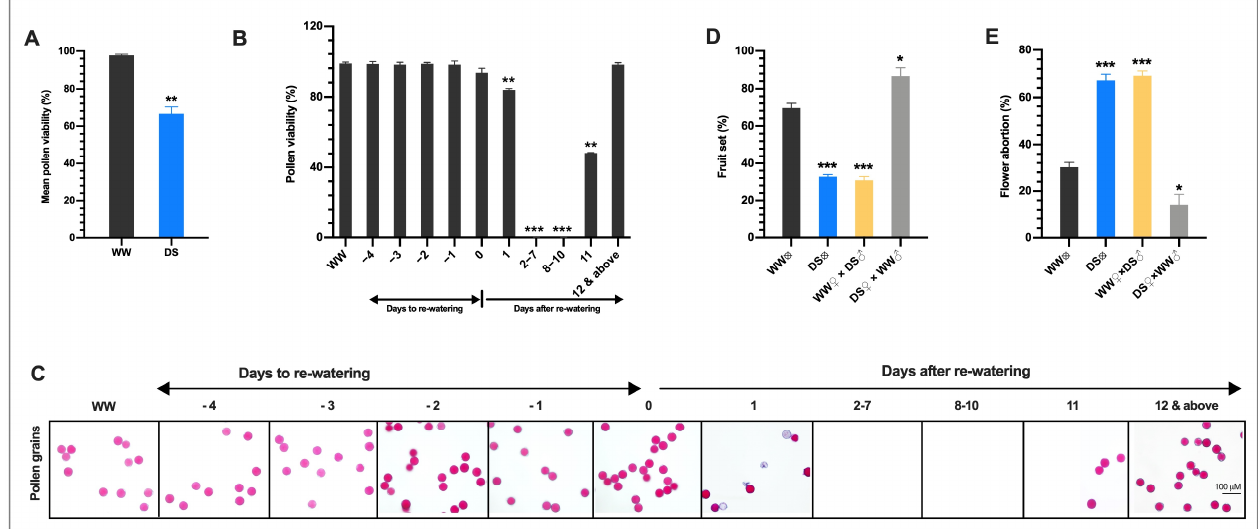
Figure 2. Drought stress reduces the fertility of the male organ. ( A ) Mean pollen viability of all flowers that opened and failed to open on tagged trusses in the DS plants from start to end of flowering. Values presented are means ±SD ( n = 150) ( B,C ). Daily mean pollen viability ( B ) and pollen ( C ) from −4 DTRW to 19 DARW. Data points represent means ±SD ( n > 10). ( D ) Fruit set ( E ) flower abortion of self-pollinated WW and DS plants, stigma of flowers on WW plants pollinated with pollen grains from DS plants